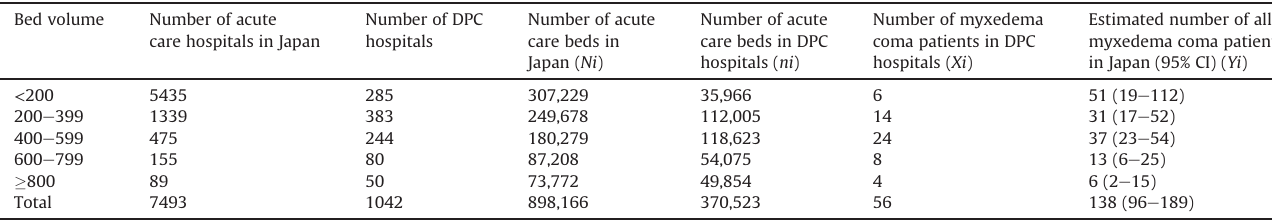
Table 3 Estimated number of patients with myxedema coma in Japan in 2012. Bed